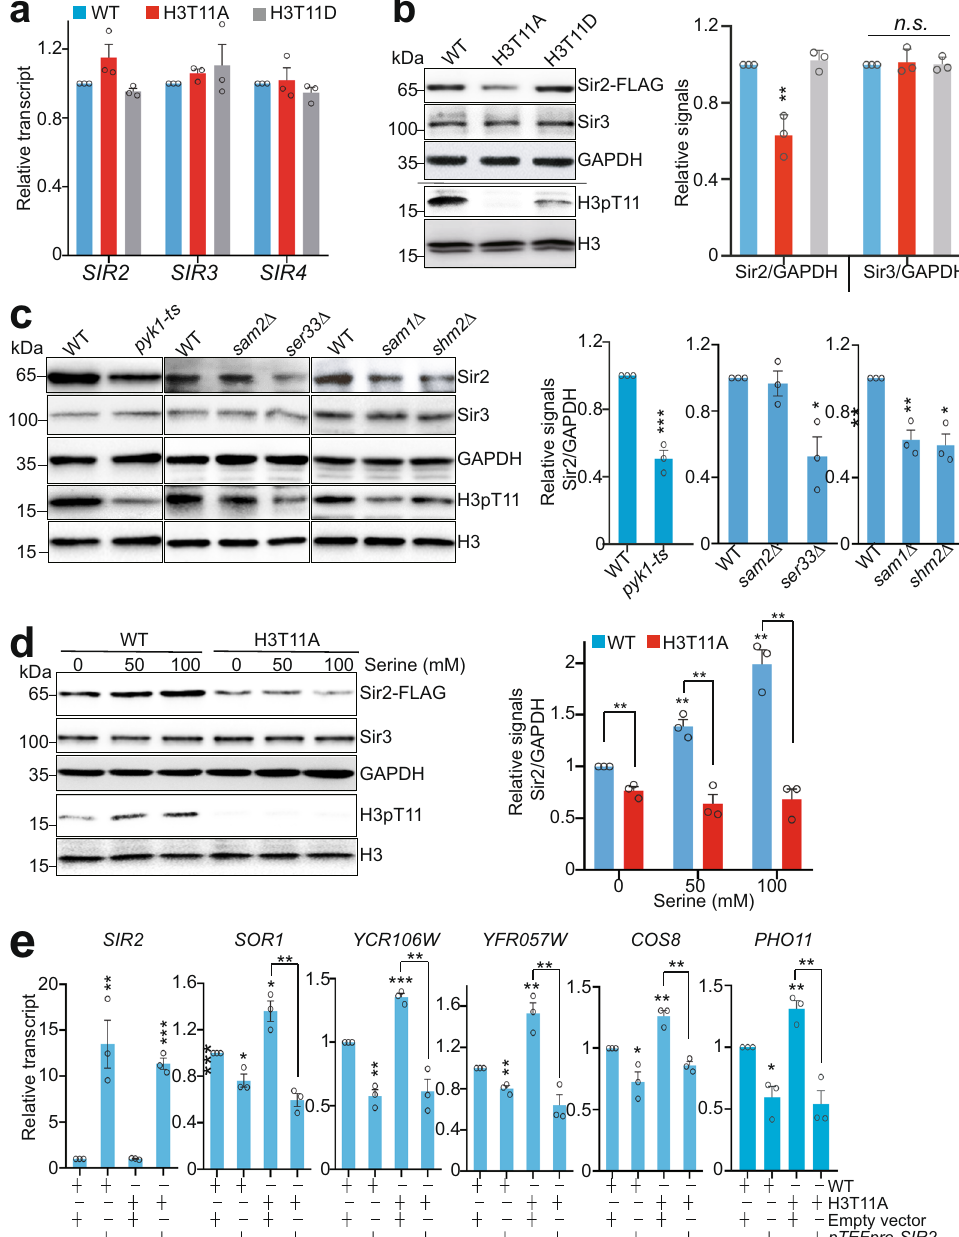
Fig. 3 SESAME-catalyzed H3pT11 is required to maintain global Sir2 protein levels. a qRT-PCR analysis of SIR2 , SIR3 , and SIR4 expression in WT, H3T11A, and H3T11D mutants. b Left panel: Western blots analysis of Sir2 and Sir3 in WT, H3T11A, and H3T11D mutants. The H3pT11 antibody can recognize the phosphomimic site (aspartate) at H3T11D with low ef fi ciency. Right panel: The relative intensities of Sir2/GAPDH and Sir3/GAPDH in left panel were quanti fi ed using ImageJ with standard error (SE). Data represent the mean ± SE of three biological independent experiments. c Sir2 protein levels were signi fi cantly reduced in WT, pyk1-ts , ser33 Δ , sam1 Δ , and shm2 Δ mutants with the exception of sam2 Δ as determined by Western blots analysis. d Serine signi fi cantly increased the global Sir2 protein levels in WT but not H3T11A mutant. e qRT-PCR analysis of SIR2 , SOR1 , YCR106W , YFR057W , COS8 , and PHO11 in WT and H3T11A mutant transformed with empty vector or vector that overexpresses Sir2 ( pTEFpro-SIR2 ). For Fig. 3a – e, the quantitative data represent means ± SE; n = 3 biological independent experiments. Statistical signi fi cance was tested using two-sided Student ’ s t test. * p < 0.05; ** p < 0.01; *** p < 0.001; n.s. no signi fi